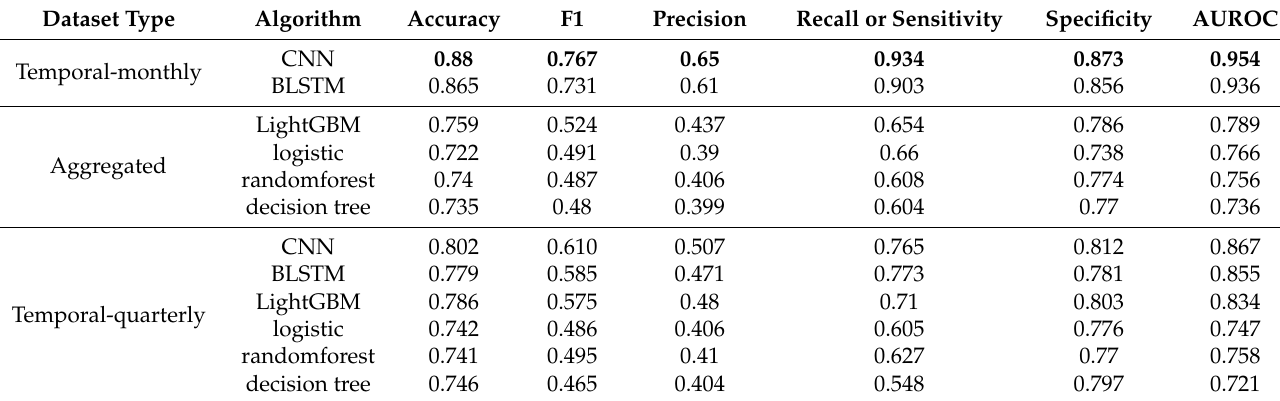
Table 4. Performance metrics for 12-month